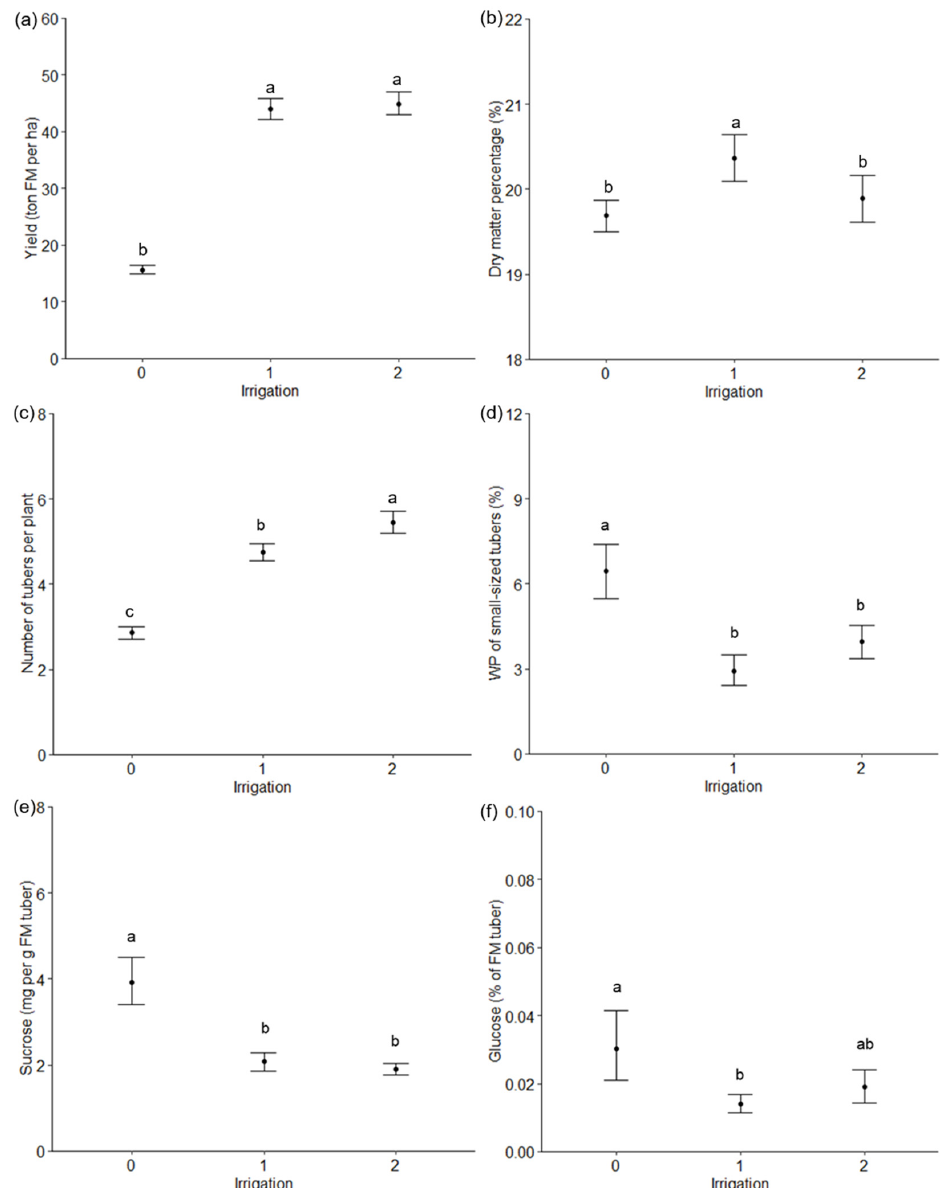
Figure 2. The main effect of irrigation on ( a ) potato fresh matter (FM) yield, ( b ) tuber dry matter content (DM%), ( c ) number of tubers per plant, ( d ) weight percentage (WP%) of small tubers (<60 mm), ( e ) sucrose and ( f ) glucose content of tubers in the 2017 experiment. The three irrigation treatment were (0) no-irrigation, (1) farmer’s irrigation and (2) full irrigation. The point indicates the mean of the observed values, and an error bar indicates the 95% confidence interval of the means. No overlap of letters between treatments refers to a statistically significant difference ( p <